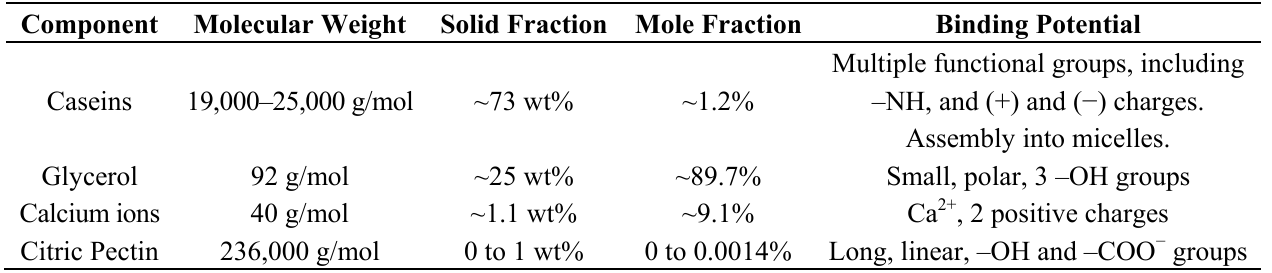
Table 2. Steric and stoichiometric considerations for CaCas/Gly/CP